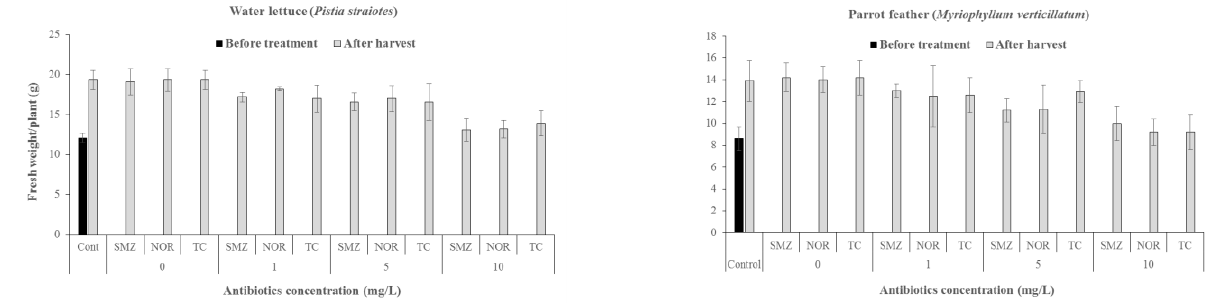
Figure 2. Fresh weights of water lettuce and parrot feather plants under various treatments at the end of the experimental period.